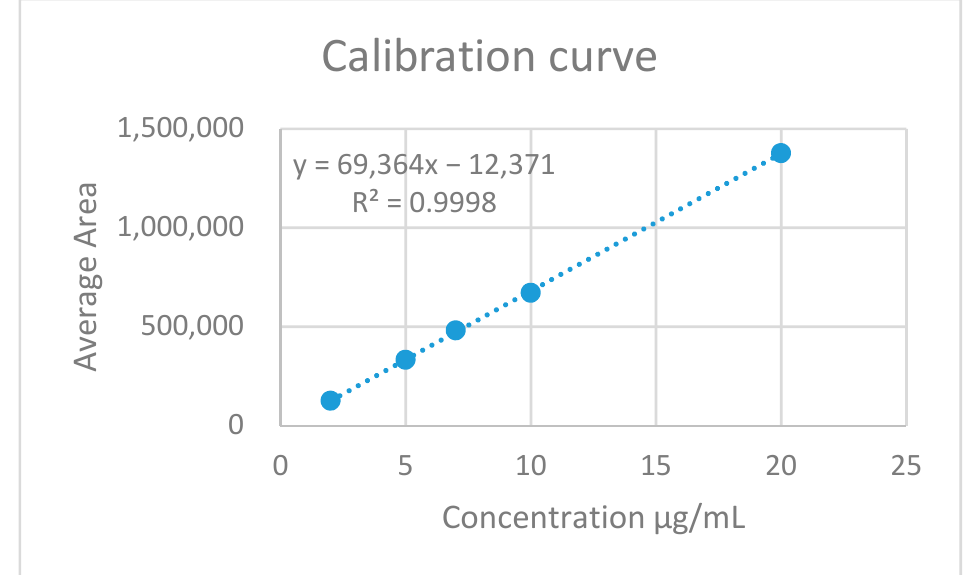
Figure 3. Calibration curve of Erlotinib standard. From the HPLC areas the amount of drug could be determined (see Table 6). Subsequently, the absolute amount of the drug is calculated. The results are shown in Table 7. Table 6. Area obtained from the sample.